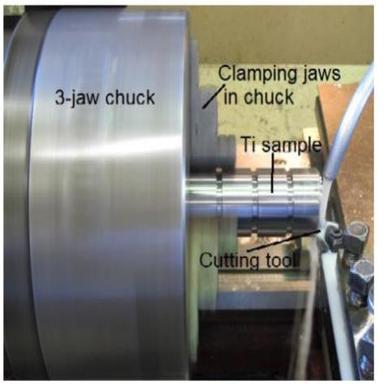
Sample shaft clamped in chuck ready for operations.